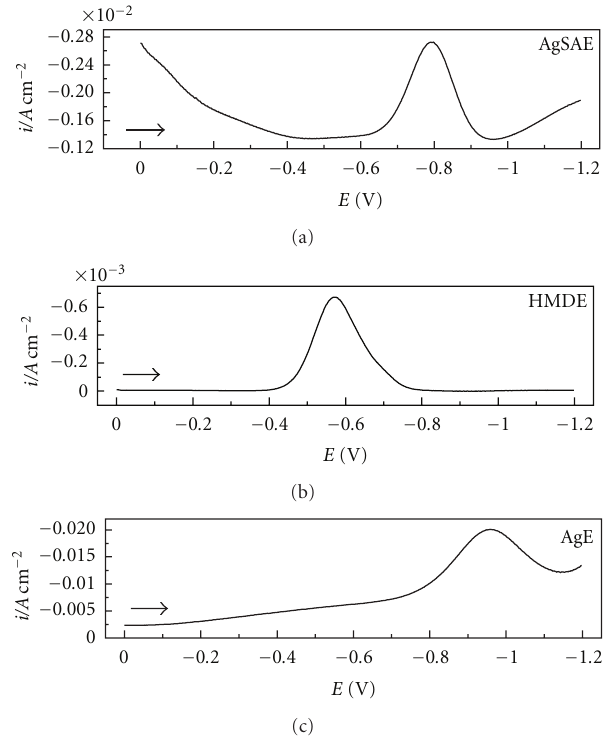
Figure 1: Square wave voltammograms for 1.05 × 10 − 4 moLL − 1 4-NP, using a 0.1moLL − 1 BR bu ff er solution at pH 7.0 and f = 100s − 1 , a = 50 mV, and Δ E s = 2mV for the AgSAE, HMDE, and AgE. Currents are standardized by the electroactive